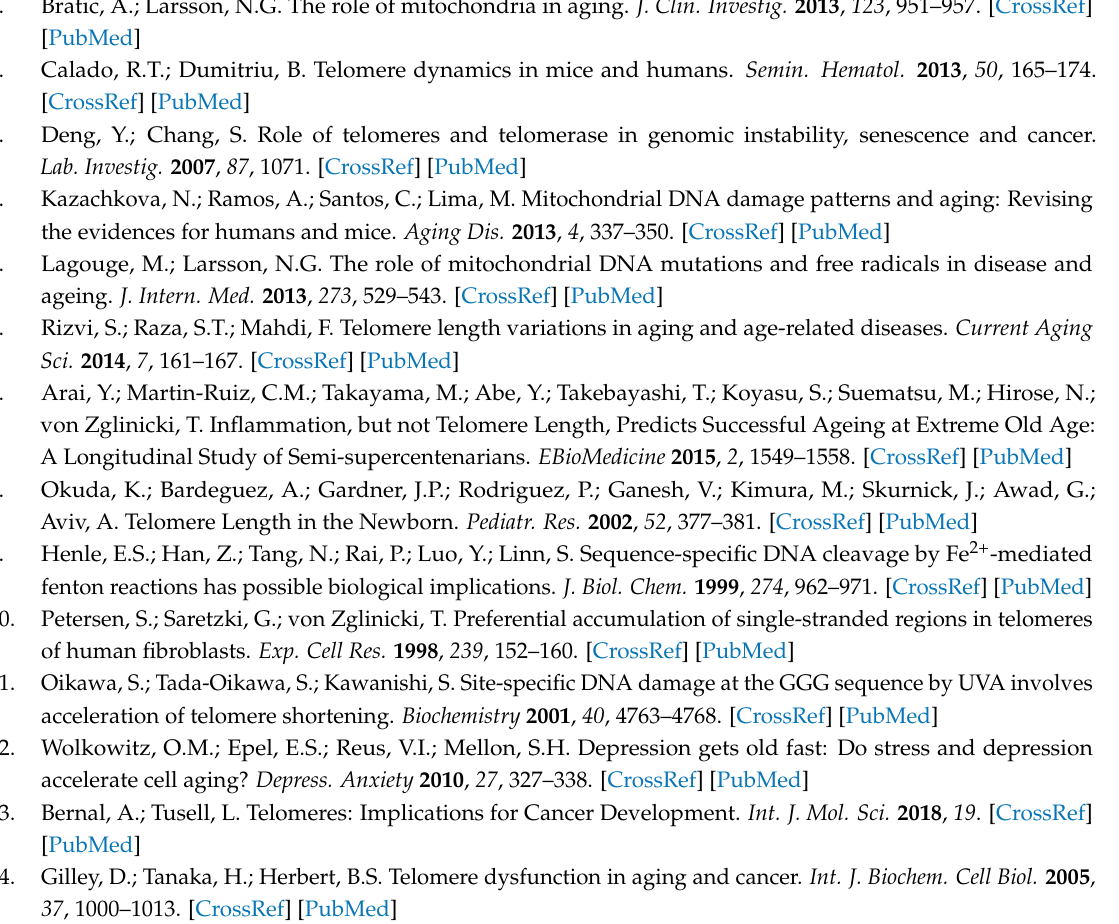
Figure S1: Comparisons of qPCR primer sets for telomere length and mitochondrial DNA copy number analysis. (A–D) Standard curves and PCR efficiencies of standard gDNA (ranged from 1.48–40 ng) by each primer set. (E–G) Melting curve analysis of PCR products amplified by each primer set. Figure S2: Telomere length change analysis using purified leukocytes and whole blood of mice aged 2–18 months. The telg–telc primer set was used for the telomere amplification. **, p < 0.01; ***, p < 0.001 compared with the value at 2 months by one-way ANOVA with Dunnett’s multiple comparison test. Figure S3: Aging standard curves for mitochondrial DNA copy number (mtDNAcn) constructed by Cox1 qPCR. The relative mtDNAcn at 2 months is normalized to 1. Slope of the linear regression line, goodness of fit ( r 2 ), and p -value (whether a slope is significantly non-zero) are provided for each curve. Figure S4: Chronic immobilization stress (CIS)-induced changes in mitochondrial DNA copy number in 12 tissues analyzed by Cox1 qPCR. Error bar is SEM. *, p < 0.05; **, p < 0.01 from unpaired Student’s t -test. Figure S5: Telomere length analysis by a telomere restriction fragment (TRF) method. Telomere lengths of spleen and kidney were analyzed using TeloTAGGG Telomere Length Assay kit (Roche Diagnostics GmbH, Mannheim, Germany). Each 1.5 µ g of gDNA was separated on 0.5% agarose gel and transferred to nylon membrane. The Digoxigenin-labeled telomere probe was hybridized and visualized by alkaline phosphatase-conjugated anti-DIG antibody. The mean TRF value was calculated according to the manufacturer’s protocol. CTL, pooled gDNA of 5 non-stressed control mice. STR, pooled gDNA of 6 chronically stressed mice. Relative telomere length by qPCR are the data in Figure 3 and Table